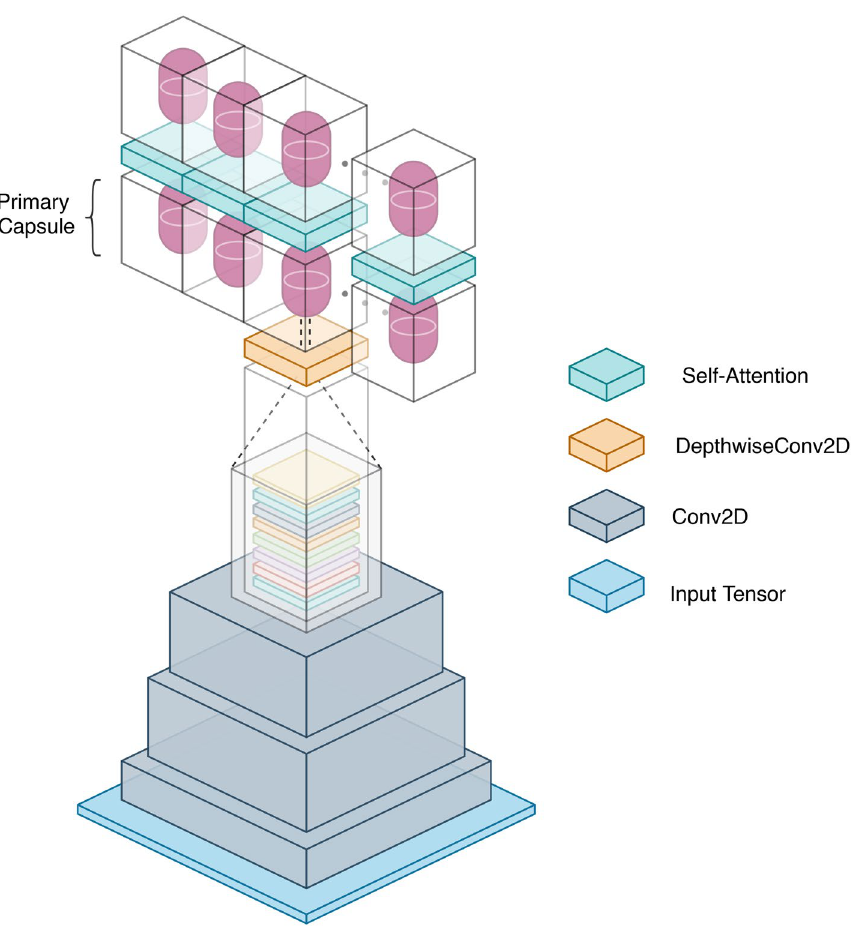
Figure 2. Schematic representation of the overall architecture of Efficient-CapsNet. Primary capsules make use of depthwise separable convolution to create a vectorial representation of the features they represent. On the other hand, the first stack of convolutional layers maps the input tensor onto a higher-dimensional space, facilitating capsules creation.